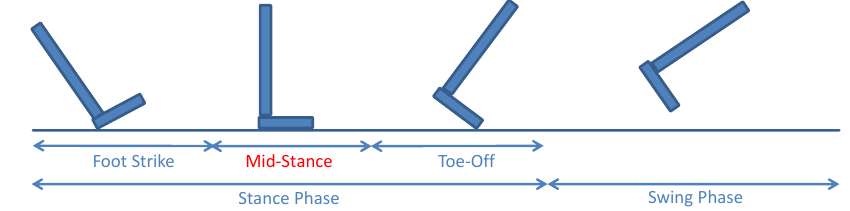
Figure 2. Phases of the gait cycle. During the mid-stance, the Zero velocity UPdaTe (ZUPT) and the Height UPdaTe (HUPT) corrections can be